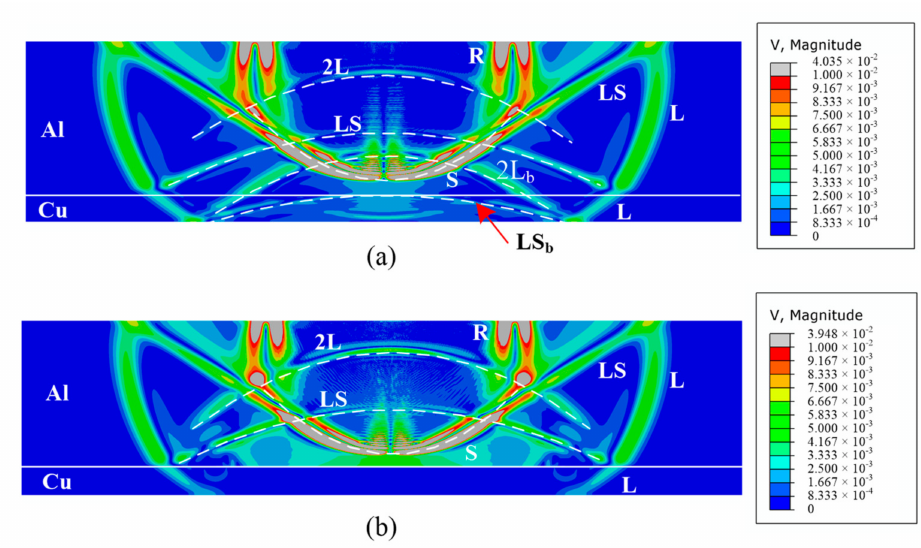
Figure 6. The total velocity field simulated in Cu/Al bimetallic composites with and without delamination defects at 0.75 µ s: ( a ) Without defect; ( b ) delamination defect width of 6